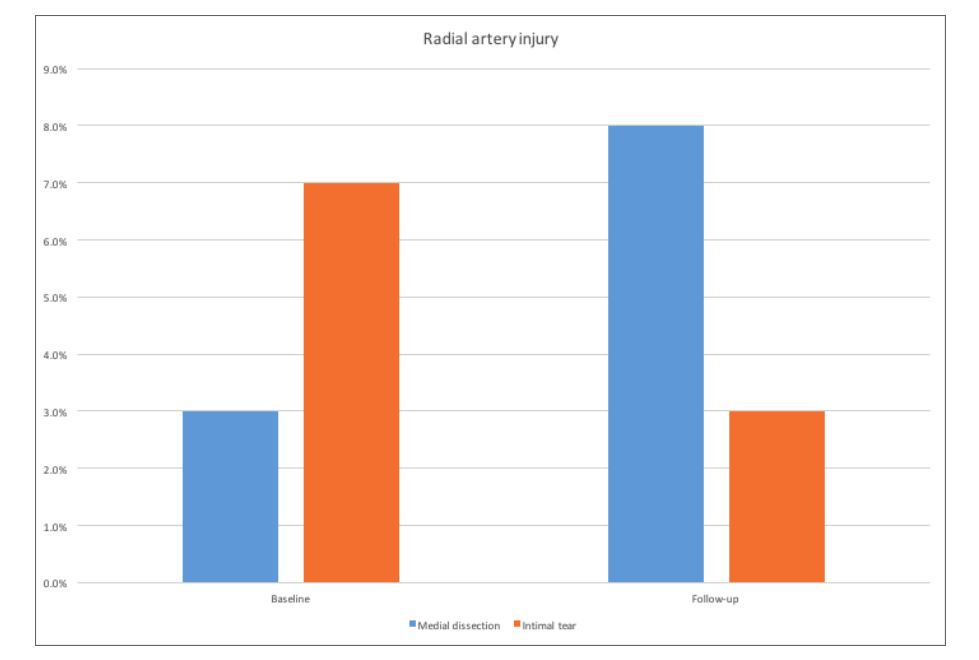
Fig. 4. injury distribution. Table 2. radial artery injuries in baseline and follow-up examination.